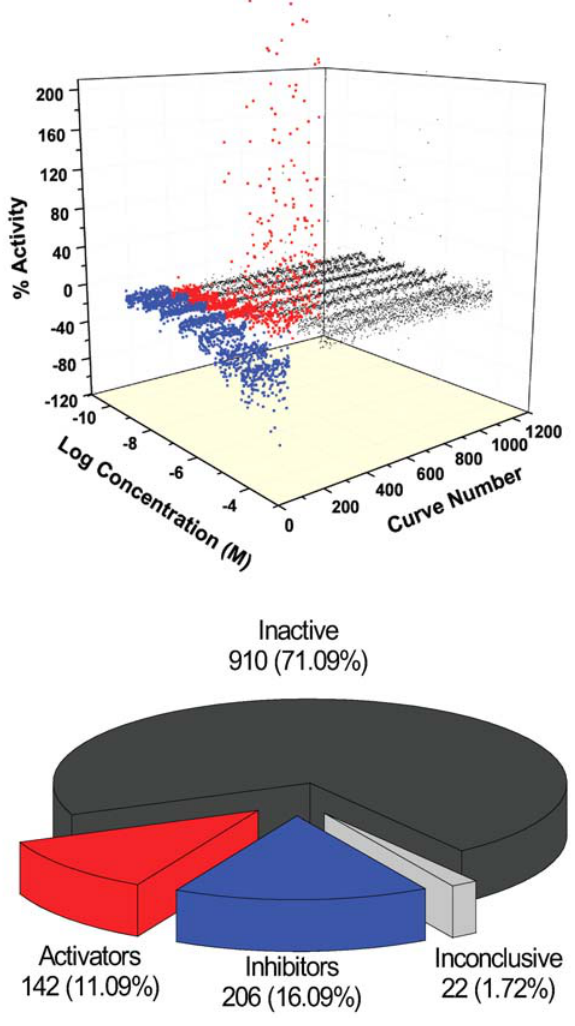
Figure 4. Cumulative results of the screen. Compounds are grouped according to inhibitor (blue), activator (red), inactive (dark grey) and inconclusive (light grey) categories.